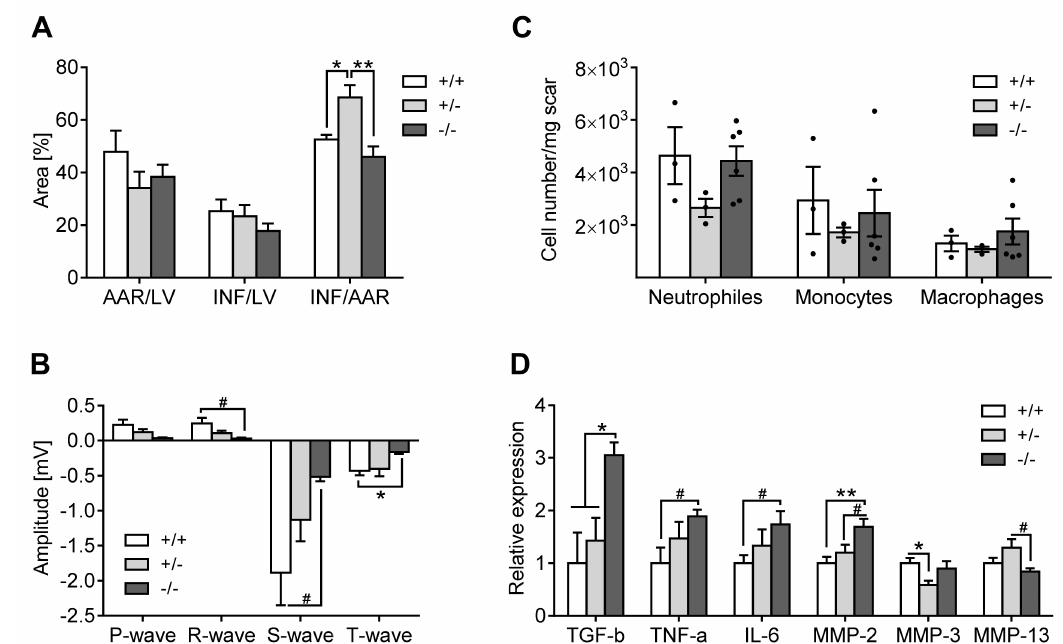
Figure 7. Infarct size quantification, electrocardiographic recordings, FACS and gene expression analysis in infarcted mice at day 3 post-op. ( A ) Evans blue/TTC staining revealed a significantly increased infarct-to-area at risk (INF/AAR) ratio in 5-HTT+/ − compared to 5-HTT+/+ and 5-HTT − / − mice. The fraction of AAR and INF relative to left ventricle (LV) was comparable among 5-Htt genotypes. ( B ) Postoperative electrocardiography (ECG) recordings showed significantly smaller R-, S- and T-wave amplitudes in 5-HTT − / − mice as compared to 5-HTT+/+ littermates. ( C ) Evaluation of immune cell subsets in the infarct area by FACS analysis revealed no differences between 5-Htt genotypes. ( D ) Gene expression analysis in the infarcted myocardium revealed significant upregulation of transforming growth factor β (TGF- β ), tumor necrosis factor α (TNF- α ), interleukin 6 (IL-6) and matrix metalloproteinase 2 (MMP2) in 5-HTT − / − relative to 5-HTT+/+ mice. Furthermore, matrix metalloproteinase 3 (MMP-3) was downregulated and matrix metalloproteinase 13 (MMP- 13) upregulated in 5-HTT+/ − mice as compared to 5-HTT+/+ and 5-HTT − / − mice, respectively. Data are shown as mean ± SEM. # p < 0.1, * p < 0.05 and ** p < 0.01; ( A ) ordinary one-way ANOVA with Tukey post hoc test, ( B , C ) Welch’s ANOVA with Games–Howell post hoc